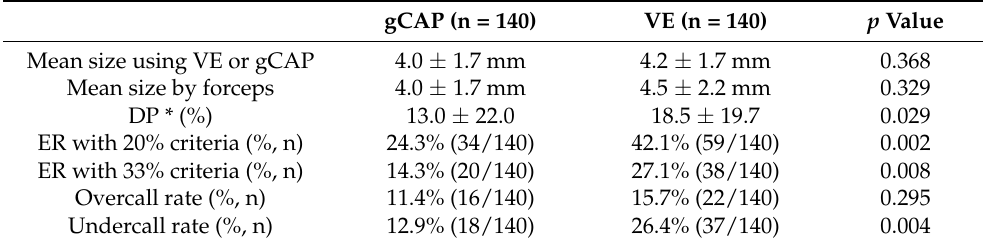
Figure 5. Error rates with limitations of 20% and 33%. Table 2. Polyp size discrepancy in measurements using a colonic cap with an external grid and by visual estimation.